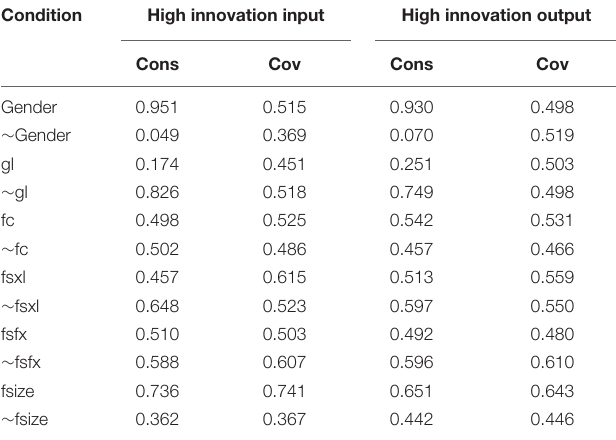
TABLE 4 | Necessity analyses for innovation input and output.